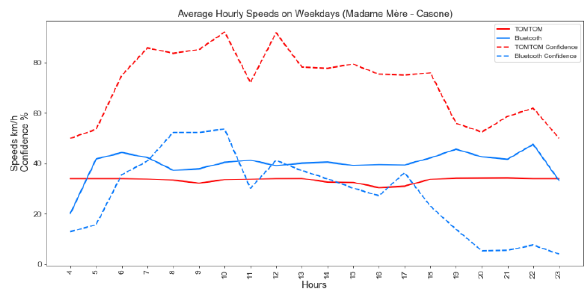
Figure 14: A comparison of TomTom and Bluetooth time-of- day average speeds and confidence values for traffic driving away from the city